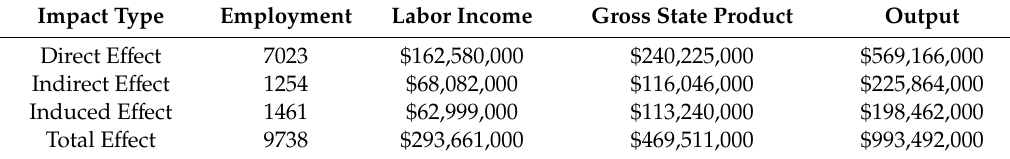
Table 6. Aggregate economic contribution of Michigan’s brewery value